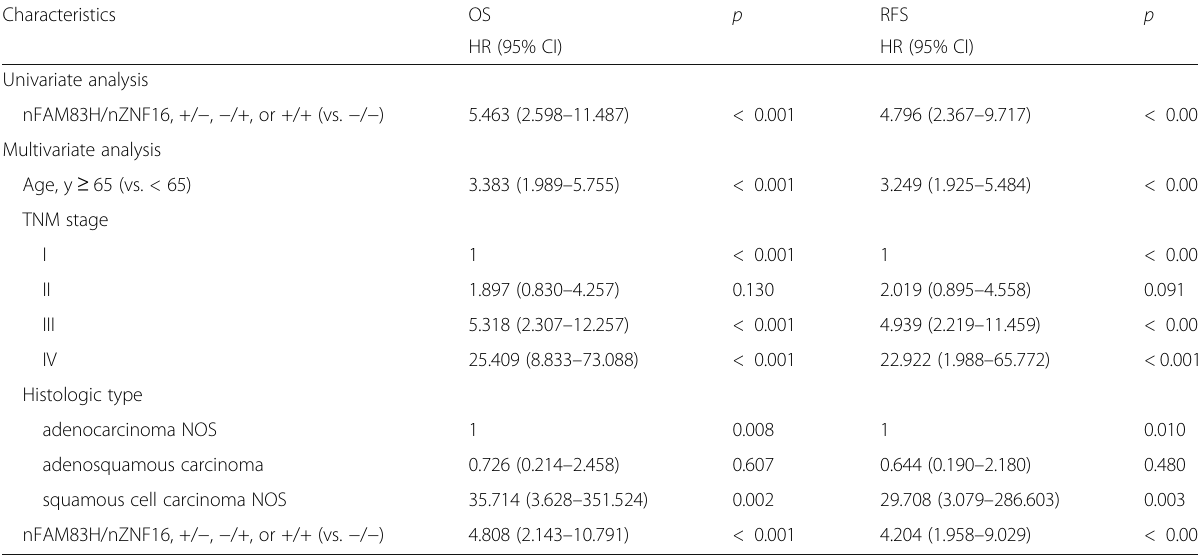
Table 6 Univariate and multivariate Cox regression analysis for overall survival and relapse-free survival according to the co- expression patterns of nuclear FAM83H and nuclear ZNF16 in gallbladder carcinomas